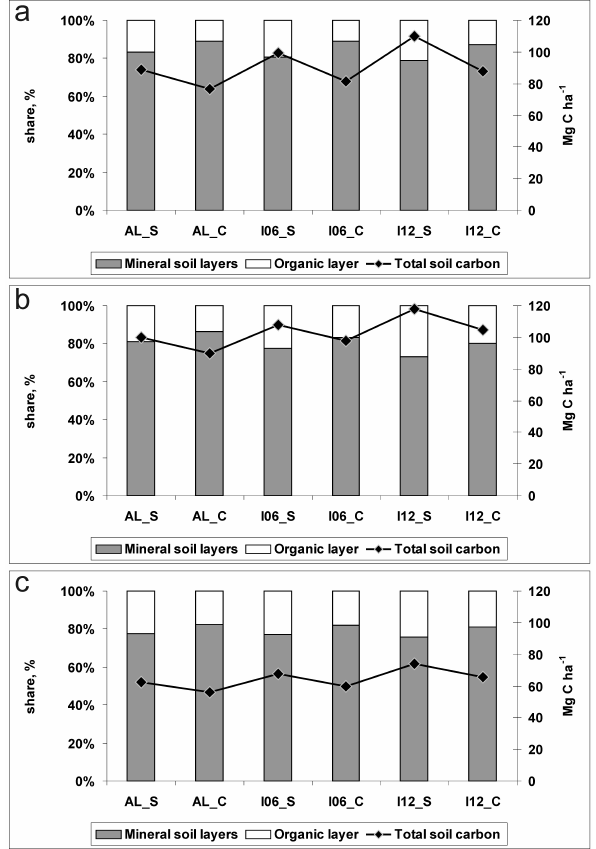
Fig. 5. Nitrogen stocks in different pools by the end of simulation with different levels of deposition of nitrogen compounds (AL – ambient level, I06 – increase of 6kg[N]ha − 1 yr − 1 , I12 – increase of 12kg[N]ha − 1 yr − 1 ) and climatic scenarios ( S – ambient cli- mate, C – climate change) for the different areas under study ( (a) – Dankovskoe forest area, (b) – Manturovskoe forest area, (c) – Zheleznodorozhnoe forest